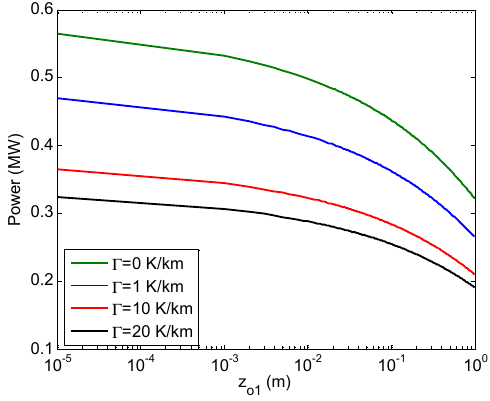
Figure 16. Effect of underlying surface roughness and free-atmosphere stability on the power output for s =